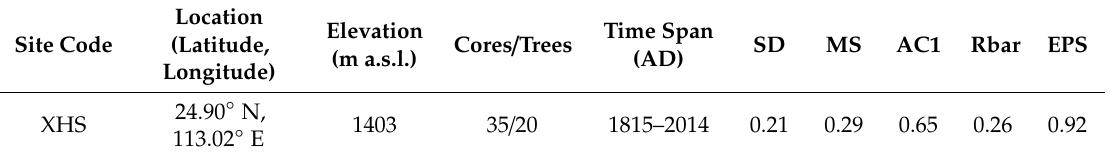
Figure 2. ( a ) Image of Pinus kwangtungensis tree core samples and ( b ) high-resolution image of annual growth layers of Pinus kwangtungensis under microscope. Table 1. Site information and tree ring chronology statistics.